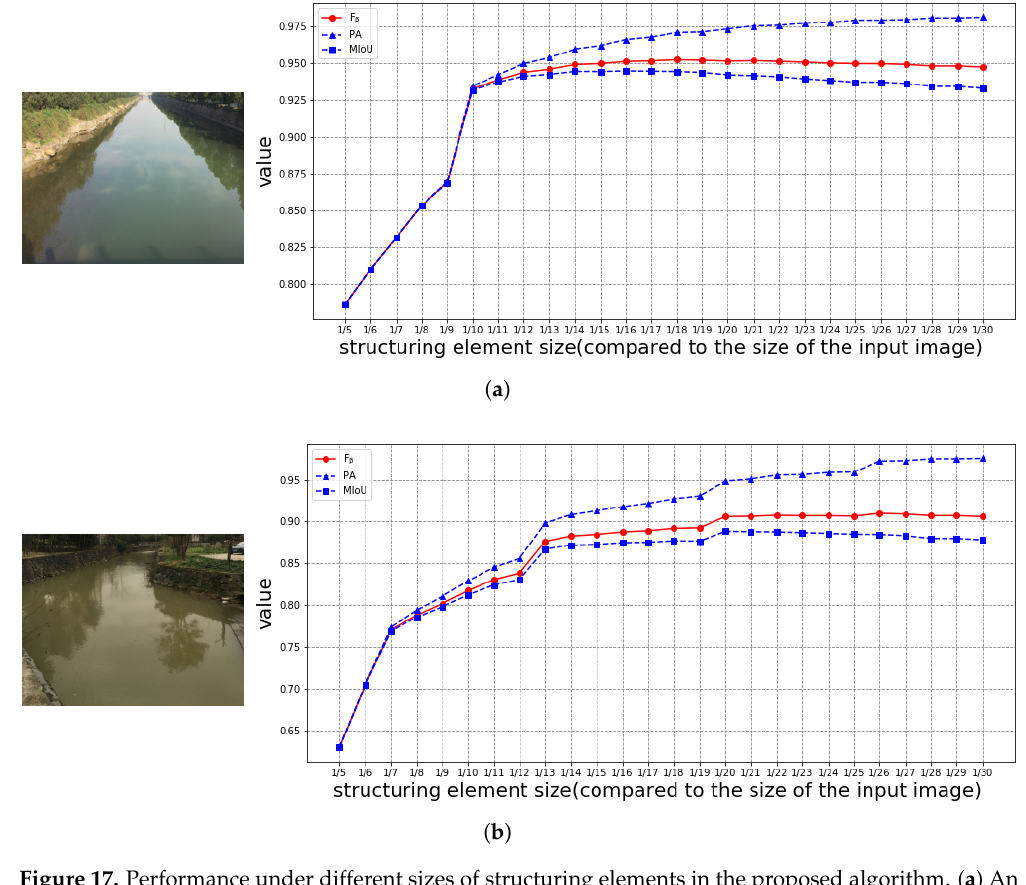
Figure 17. Performance under different sizes of structuring elements in the proposed algorithm. ( a ) An example of simple river scene; ( b ) An example of complex river